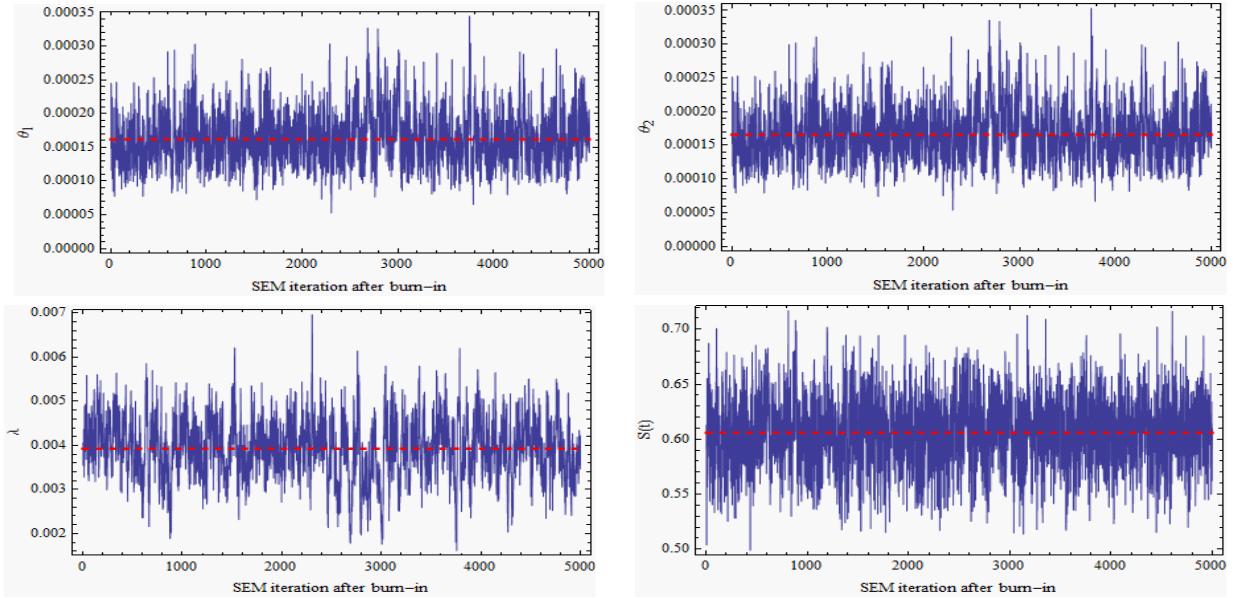
Fig. 4. Traces plot of SEM samples based on the data from Hoel (1972). Horizontal lines are the estimated parameter values.